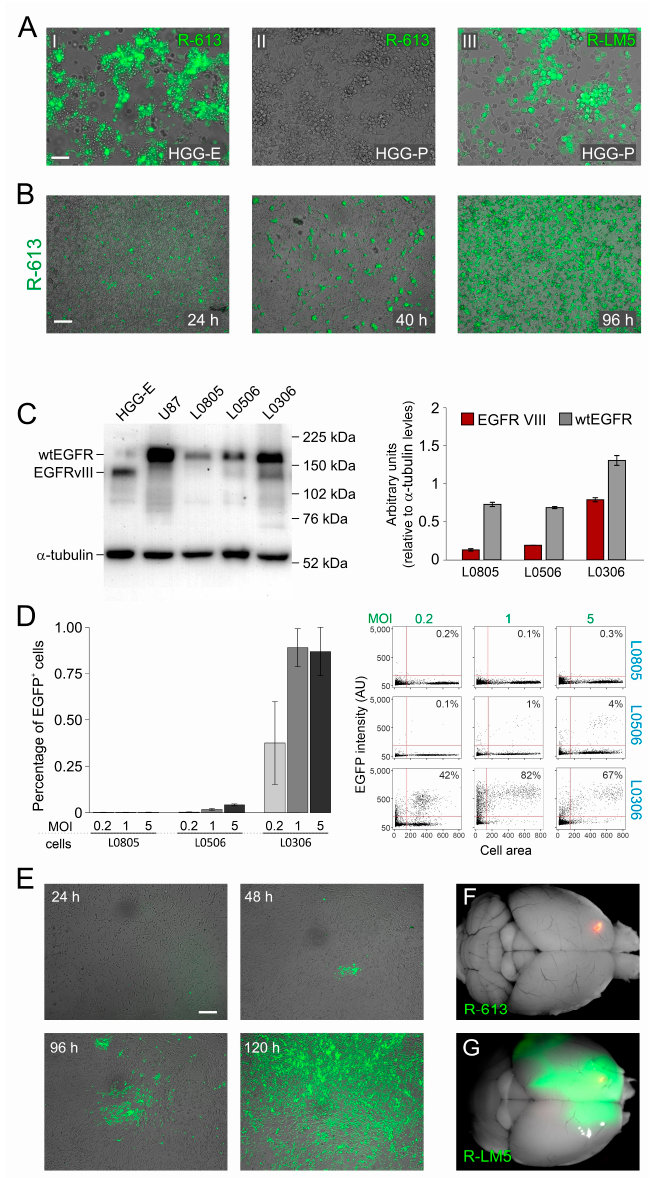
Figure 1. Specificity and safety of oHSV R-613 infection of glioma cells. ( A ) Merged fluorescence and bright-field microphotographs of murine glioma cultures expressing EGFRvIII 96 h after infection by R-613 at MOI 1 PFU/cell (I); expressing PDGF-B 72 h after infection by R-613 at MOI 5 PFU/cell (II); expressing PDGF-B 24 h after infection by R-LM5 at MOI 0.2 PFU/cell (wild-type tropism) (III). ( B ) Merged fluorescence and bright-field microphotographs showing R-613 spread in murine glioma cultures expressing EGFRvIII and infected at MOI 0.3 PFU/cell. ( C ) Quantification of wtEGFR and EGFRvIII protein expression by Western blot in the indicated glioma cell cultures. ( D ) Quantification, based on EGFP expression, of the fraction of human glioma cells infected after 24 h by R-613 at the indicated MOI. Dot blots show a representative experiment. ( E ) Merged fluorescence and bright-field microphotographs showing R-613 spread in EGFRvIII-expressing human glioma cells infected at MOI 0.1 PFU/cell at the indicated time-points. ( F , G ) Representative dorsal images of brains from NOD/SCID mice treated with R-613 ( F ) or RLM-5 ( G ) viruses. Scale bars: 25 µm ( A ), 50 µm ( B , E ).